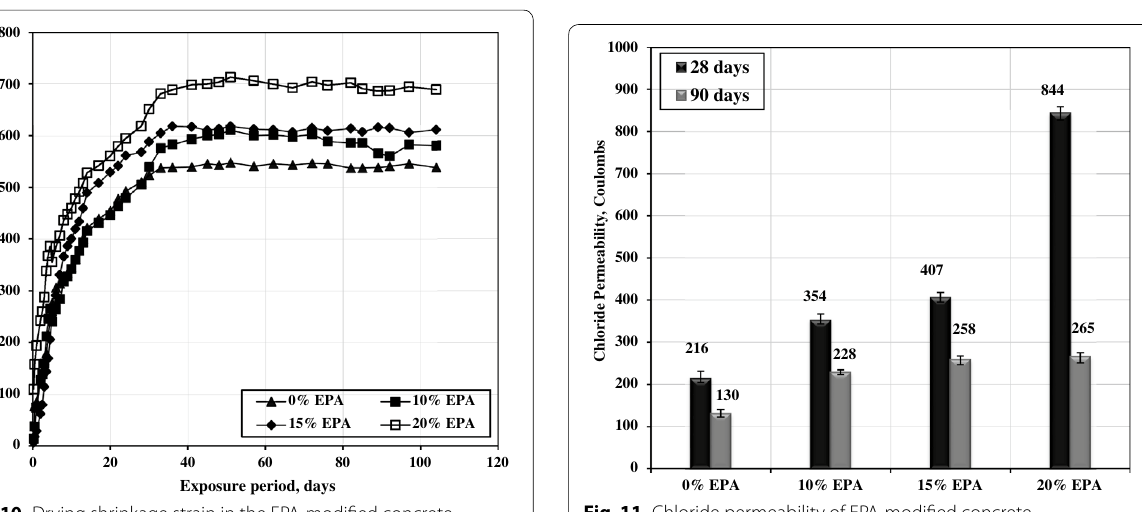
Fig. 10 Drying shrinkage strain in the EPA-modified concrete. Fig. 11 Chloride permeability of EPA-modified